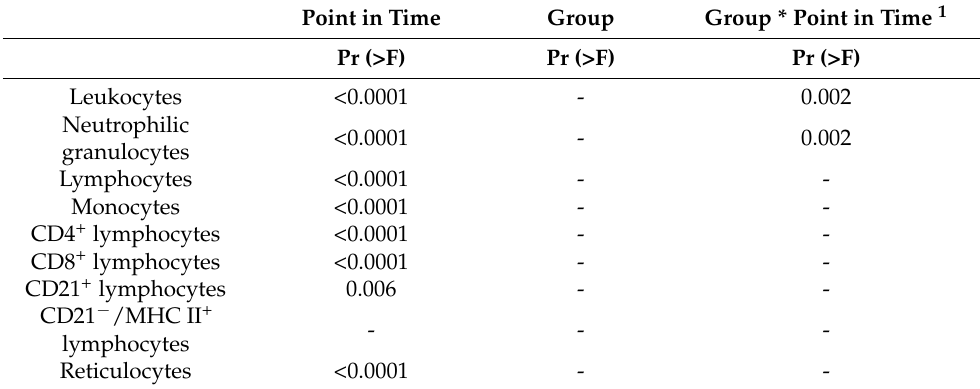
Table 3. Two-way analysis of variance (ANOVA).